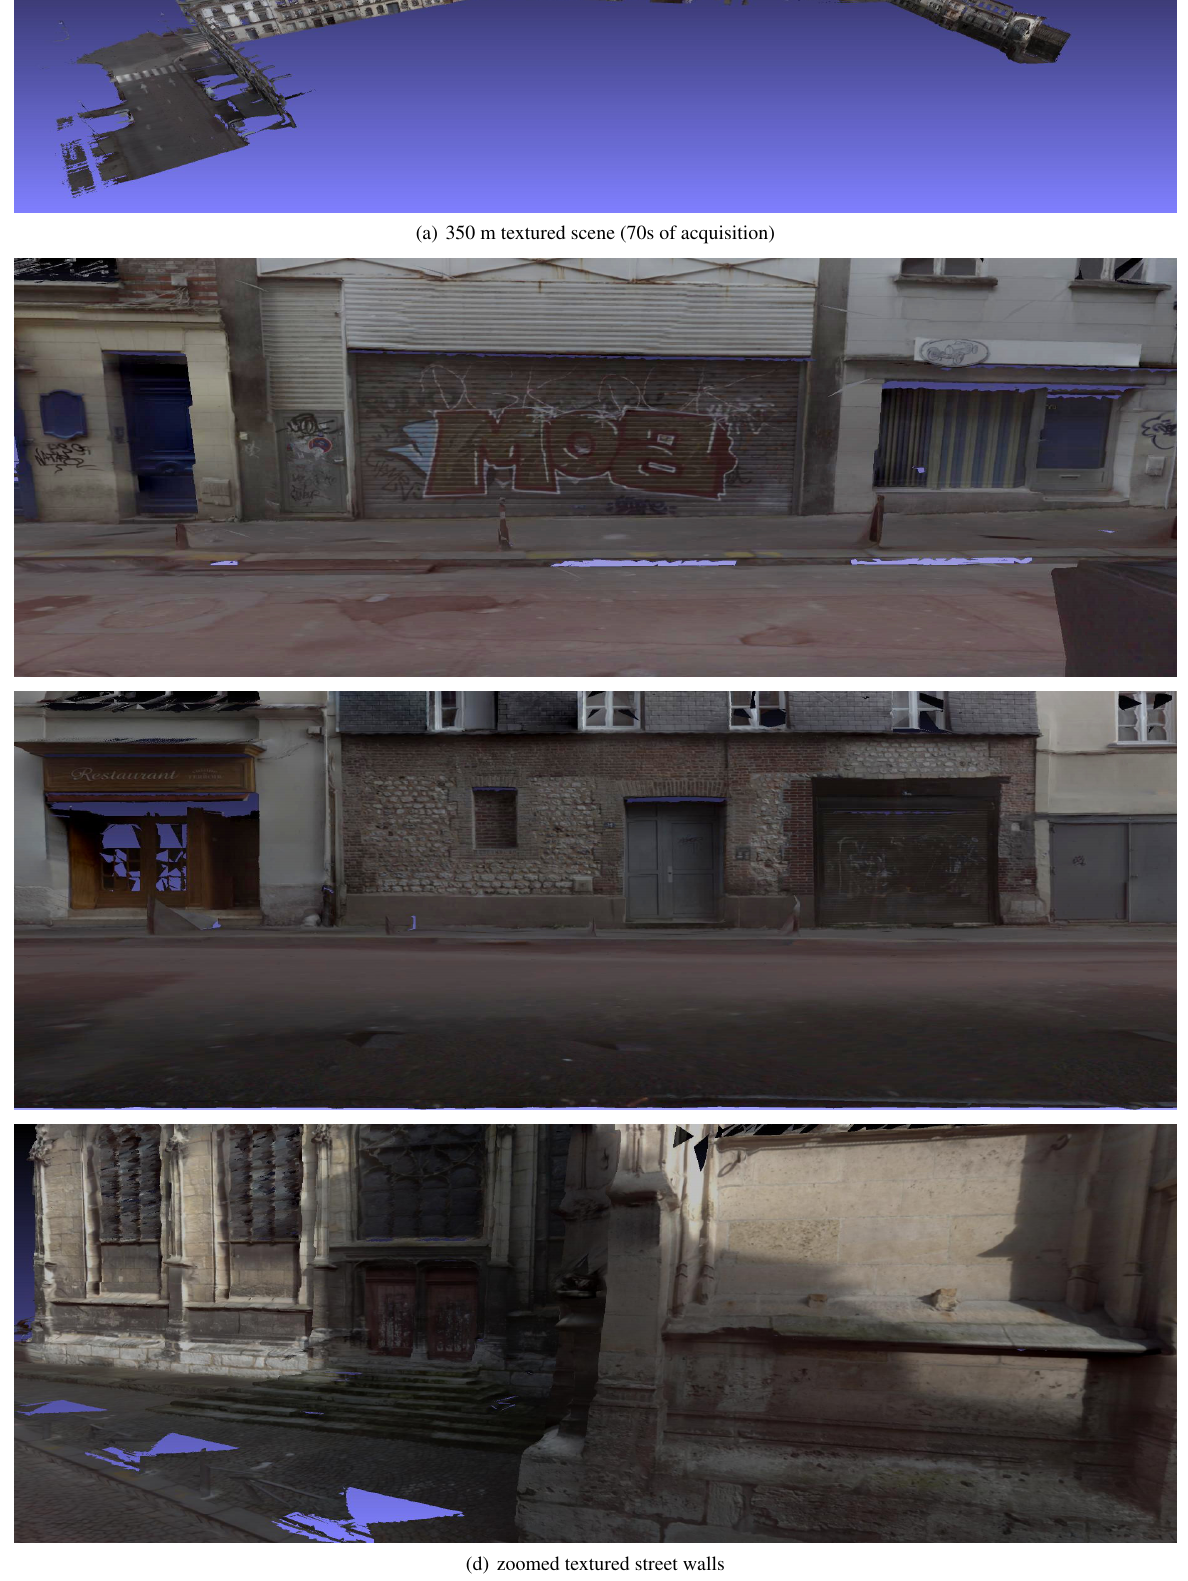
Figure 10. Samples of textured scenes from Rouen,